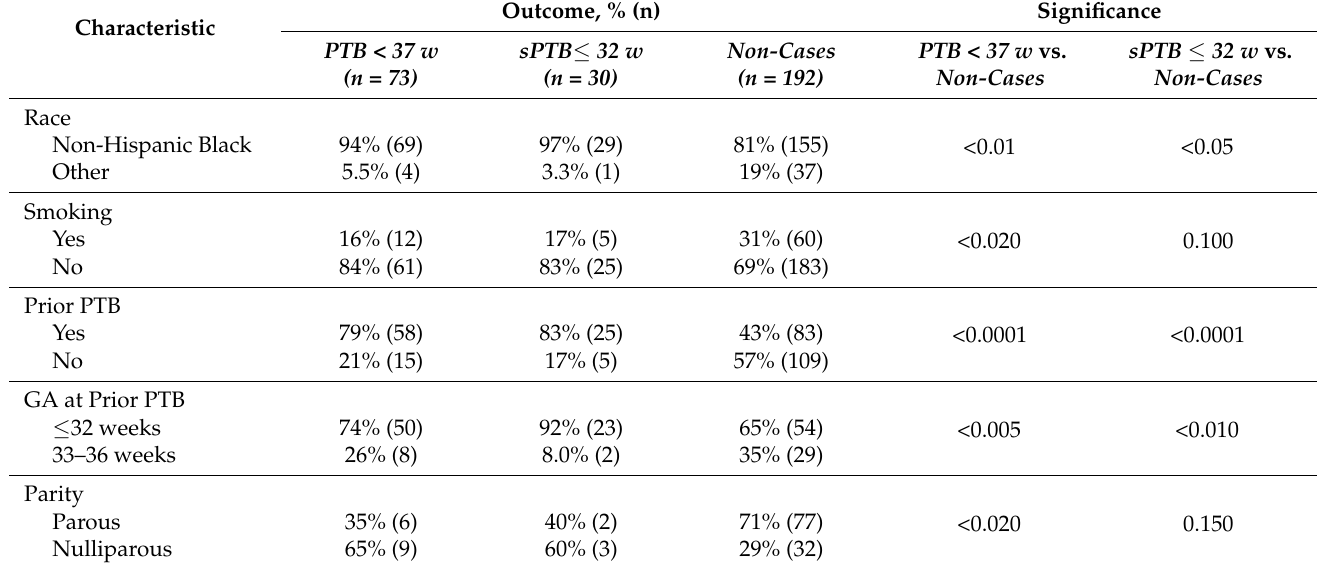
Table 2. Relationship between maternal characteristics and preterm birth in current pregnancy.